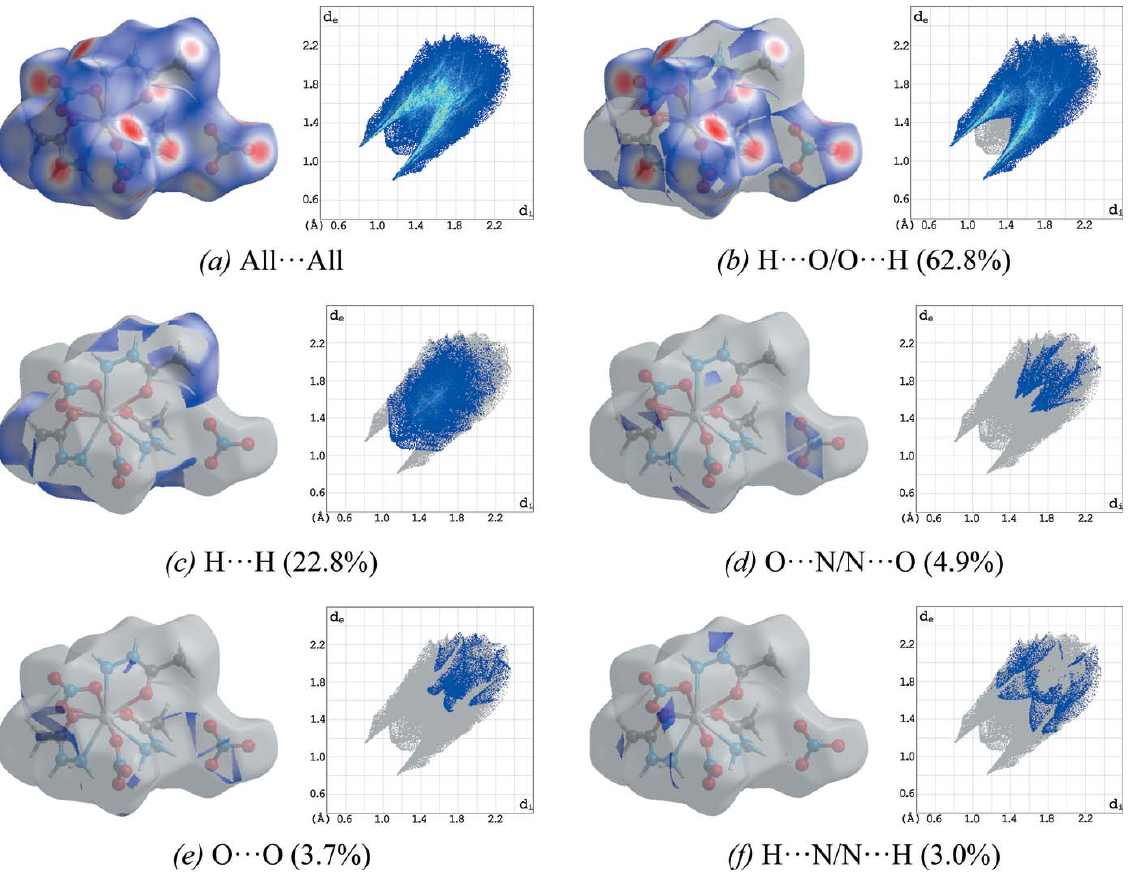
Figure 7 Two-dimensional fingerprint plots of 1 , showing ( a ) all interactions, and those delineated into ( b ) H (cid:2)(cid:2)(cid:2) O/O (cid:2)(cid:2)(cid:2) H, ( c ) H (cid:2)(cid:2)(cid:2) H, ( d ) N (cid:2)(cid:2)(cid:2) O/O (cid:2)(cid:2)(cid:2) N, ( e ) O (cid:2)(cid:2)(cid:2) O, and ( f ) H (cid:2)(cid:2)(cid:2) N/N (cid:2)(cid:2)(cid:2) H contacts [ d e and d i represent the distances from a point on the Hirshfeld surface to the nearest atoms outside (external) and inside (internal) the surface, respectively].